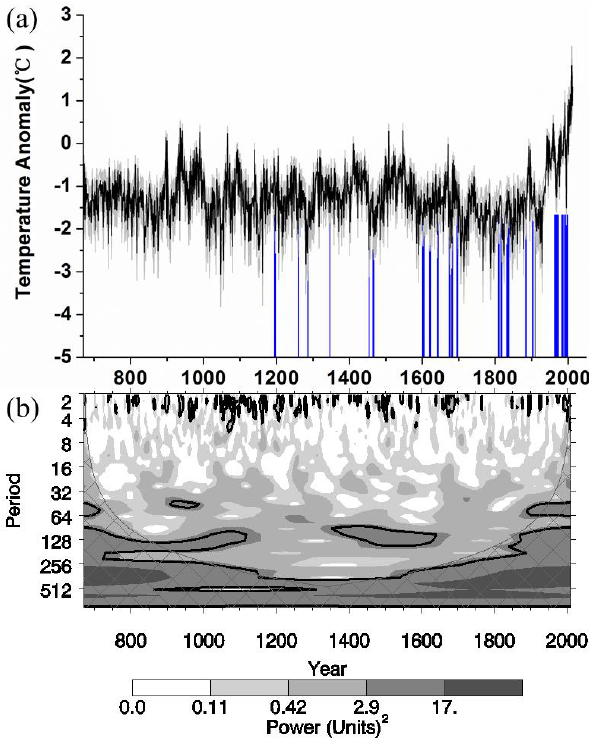
Fig. 7 (a), our reconstructed temperature in the central Qilian Mountains and 95 % confidence level (grey bars), the black dark lines indicate the 31-year running mean of our reconstruction. The vertical blue lines indicate 21 volcanic events during AD 1000-1999. (b), the wavelet power spectrum of our temperature reconstruction series. Cross-hatched regions represent the cone of influence where zero-padding of the data was used to reduce variance using a Morlet wavelet. Black contours indicate significant modes of variance with a 5% significance level using an autoregressive lag-1 red-noise background spectrum (Torrence and Compo, 1998).